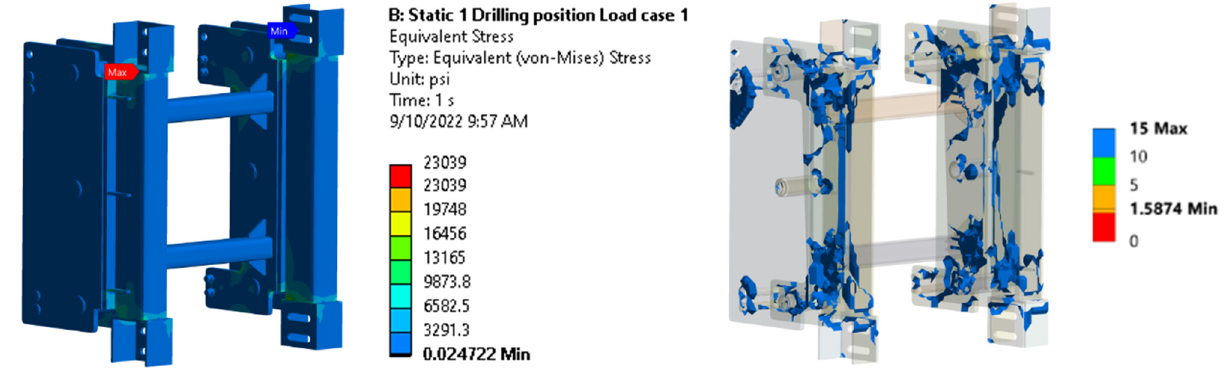
Figure 6: Equivalent ( von Mises ) stress and safety factor plot for load case 1 – Drilling standby position.